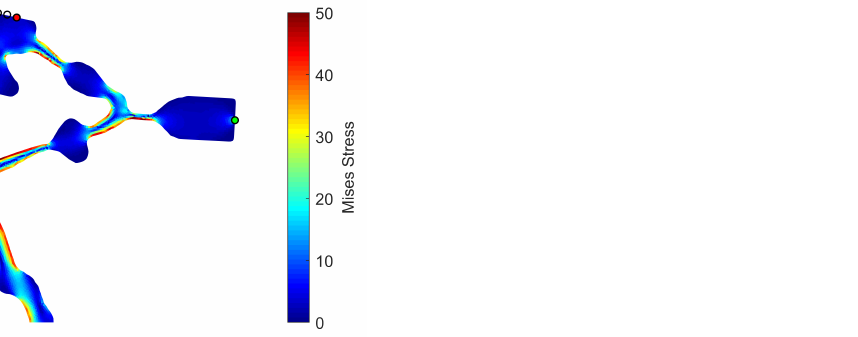
Figure 7. Path generating example mechanism topology with smoothed boundary based on Figure 6f: σ ) = 53.7 MPa (5283 solid elements/0 void 1.65 mm, max ( u out,x = 9.09 mm, u out,y = − (cid:101)